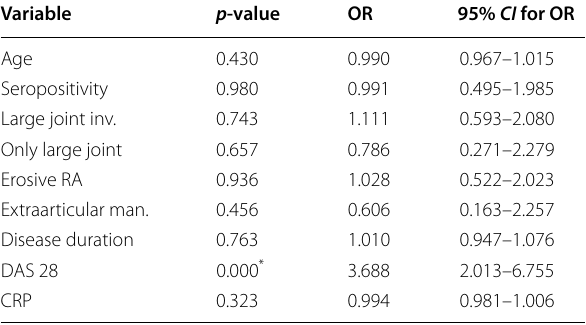
Table 2 Logistic regression analysis of the impact factors on remission in LORA